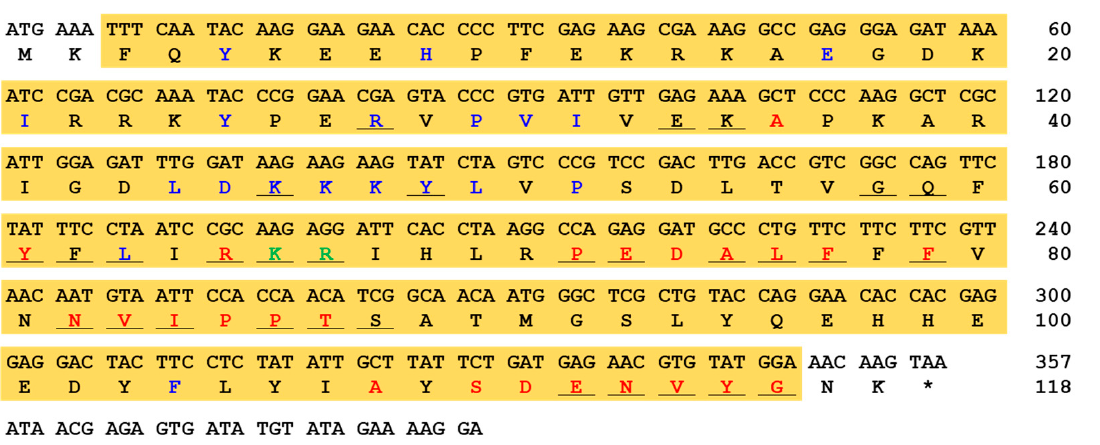
Figure 1. Nucleotide and encoded polypeptide sequence of AaAtg8 . The asterisk denotes stop codon. The autophagy protein Atg8 ubiquitin-like domain is shaded in yellow. The Atg7 interaction sites (thirty amino acid residues) are underlined. Further, the Atg4 interaction sites (twenty four amino acid residues) are shown in red text. The peptide binding site (nineteen amino acid residues) and key conserved lysine residues (K66 and R67) are highlighted in blue and green text, respectively. The pairwise alignment of the AaAtg8 nucleotide sequence from the Korean and Chinese strains (GenBank: MH243747.1) of Ae. albopictus revealed highly conserved sequences differing at only one nucleotide residue (A 216 in AaAtg8- Korean strain and T 216 in AaAtg8 -Chinese strain) (Figure 2a). The protein sequences of Aa Atg8 from each strain were found to be identical (Figure 2b).